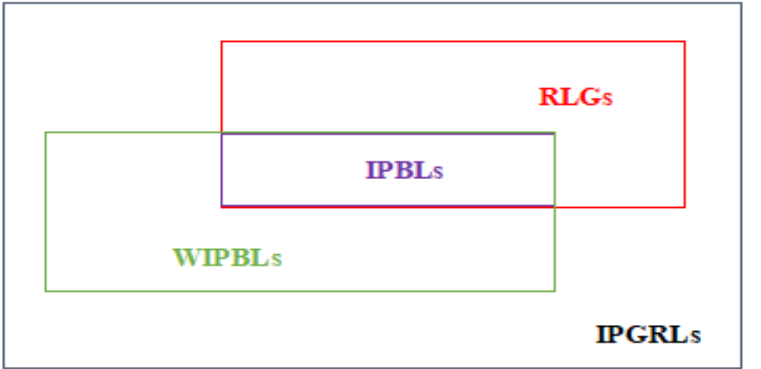
Figure 2. Relationship of the several kinds of non-commutative algebras considered in the